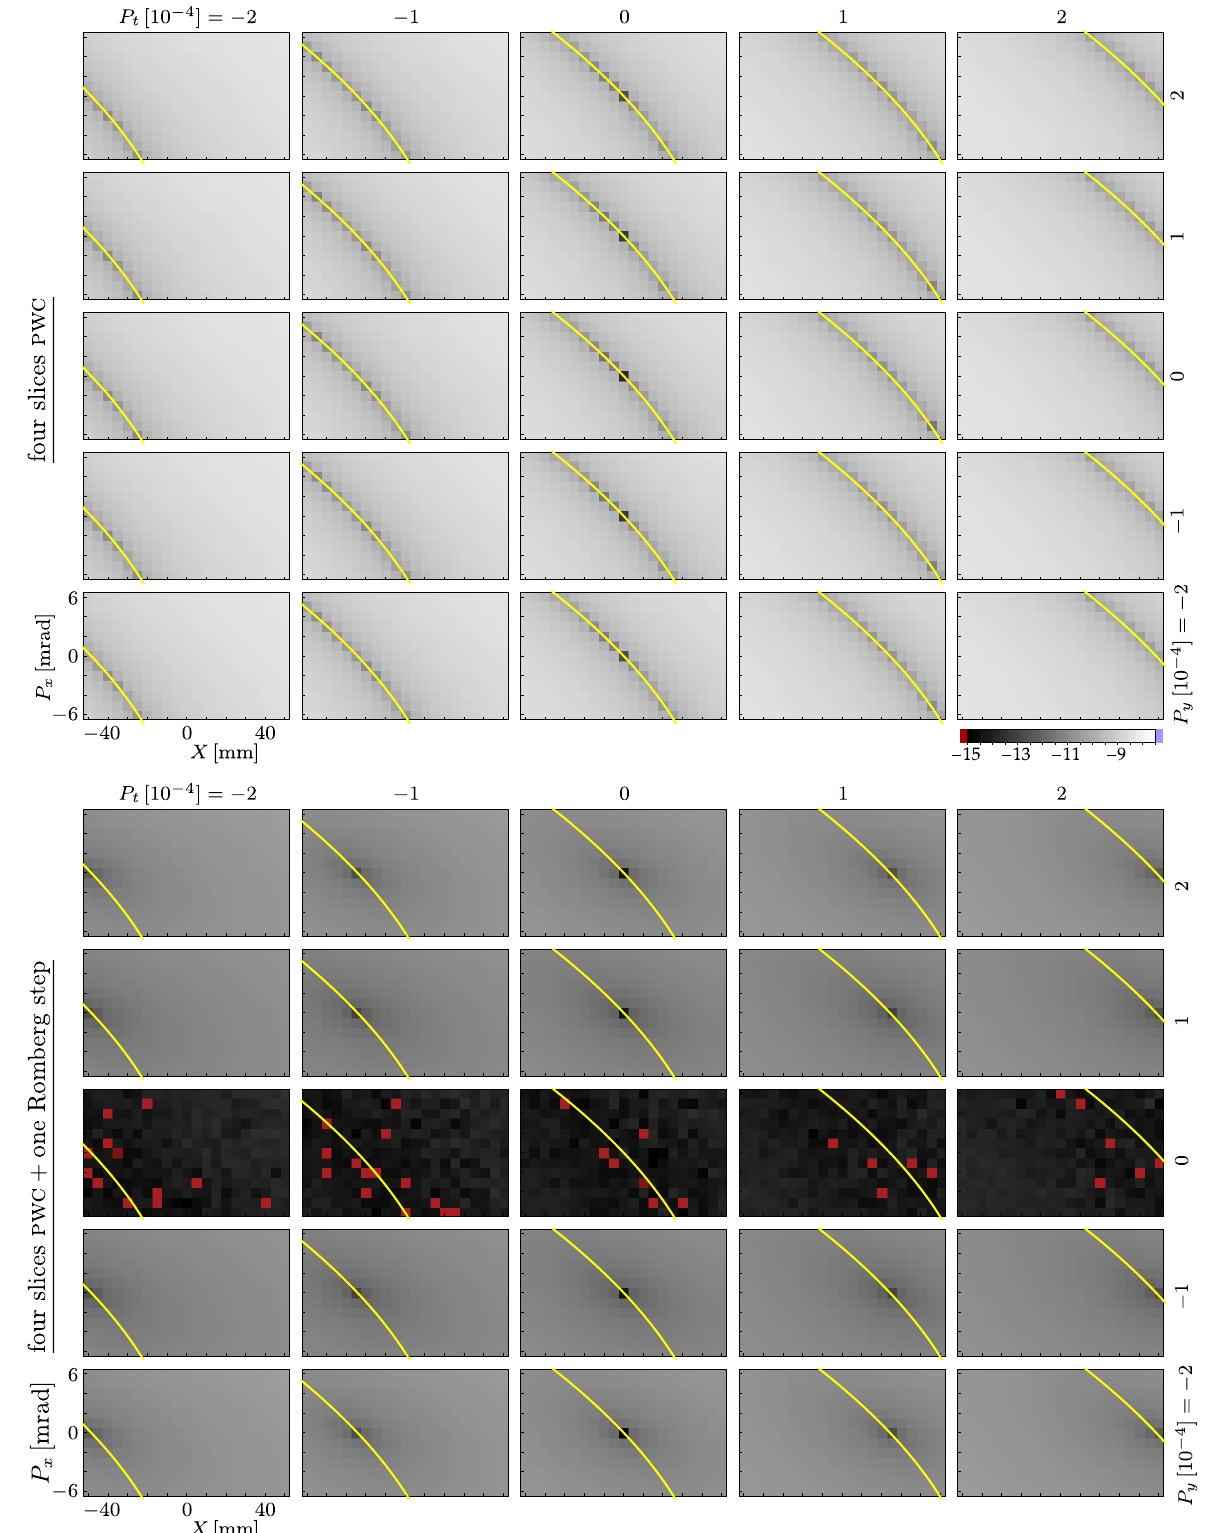
FIG. 11. Absolute error in the computed spin using eight slices across a RHIC dipole for a range of initial conditions. See also the caption of Fig. 10. The two sets of 25 graphics correspond to PWC spin integration (upper set) and PWC plus one Romberg iteration (lower